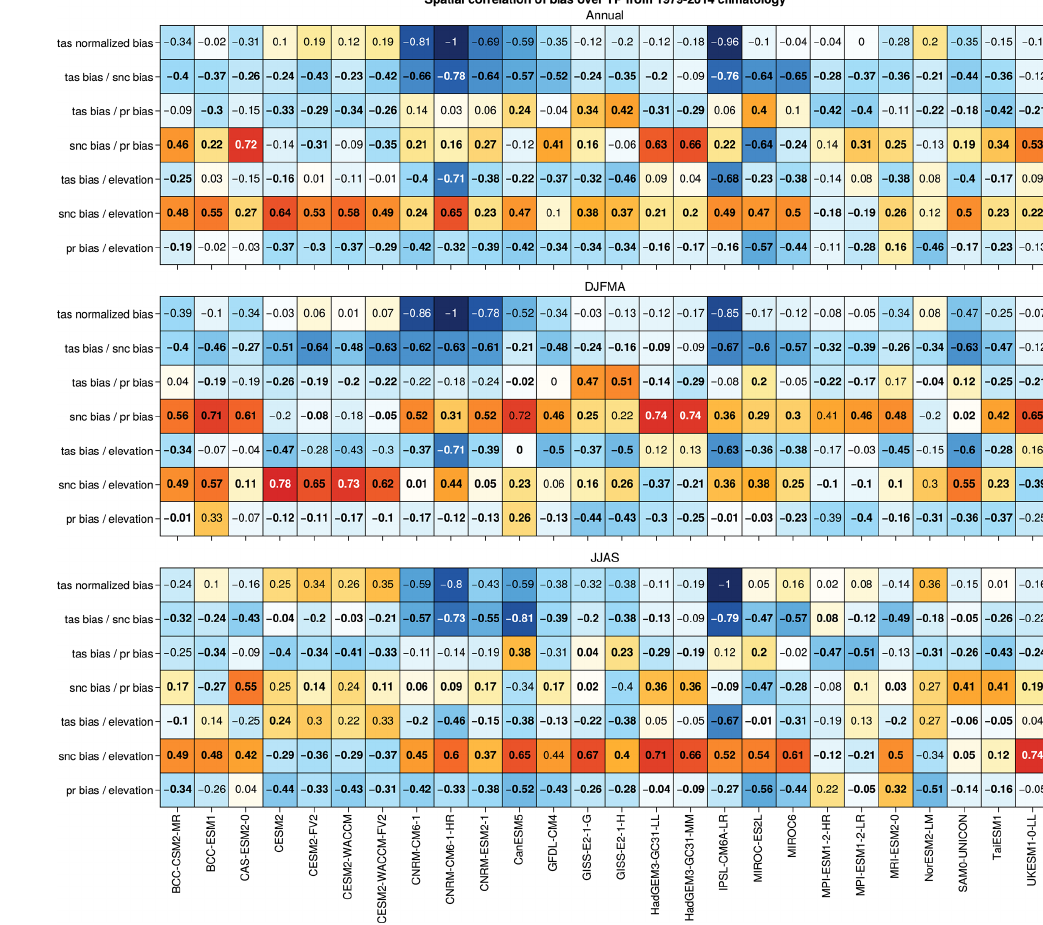
Figure C3. Same as Fig. 4 but for TP regional and seasonal